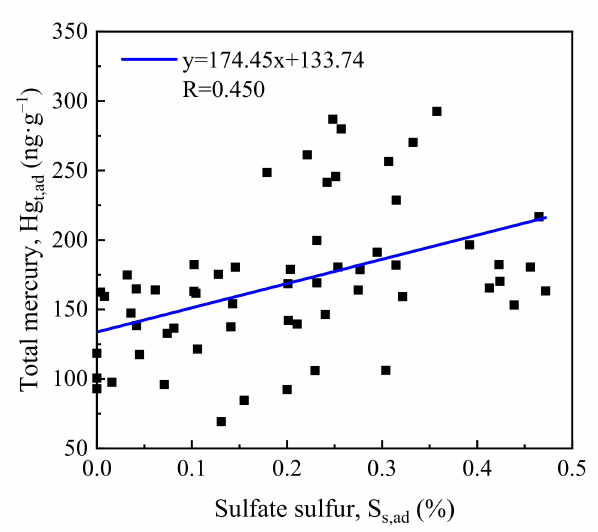
Figure 11. Correlation between Hg and sulfate sulfur in 59 coal samples.